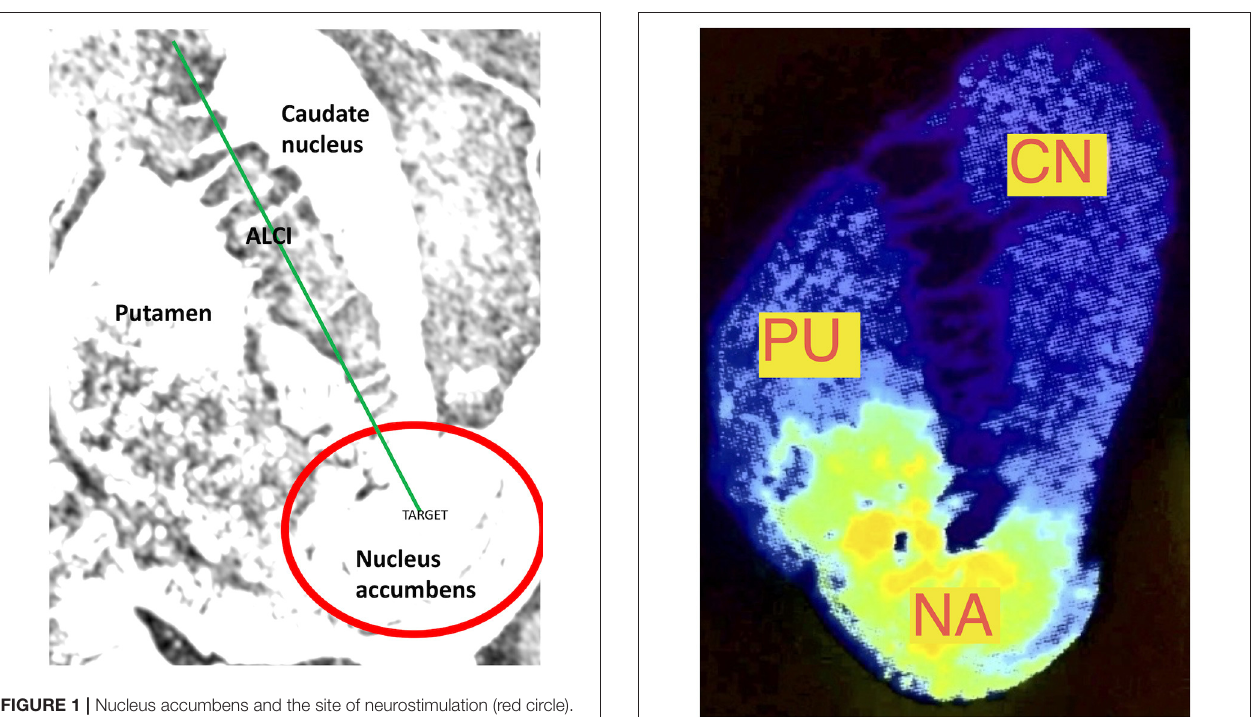
FIGURE 1 | Nucleus accumbens and the site of neurostimulation (red circle).